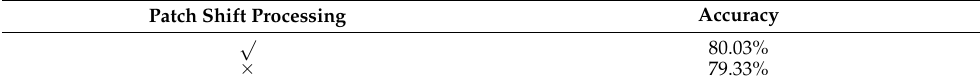
Table 11. Ablation study on the patch shift